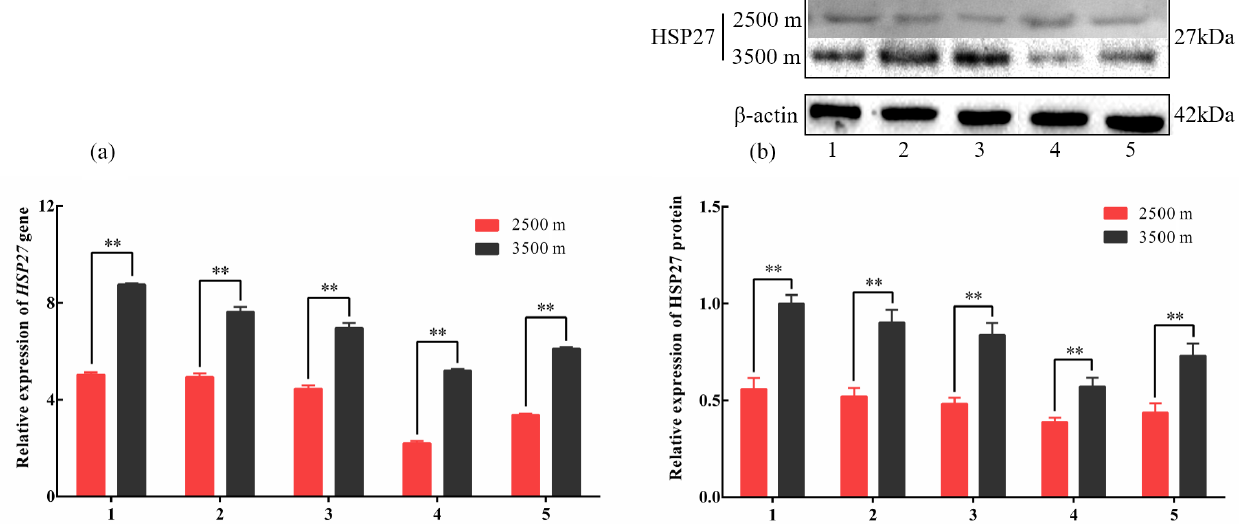
Figure 3. The expression levels of HSP27 mRNA (a) and protein (b) in five tissues obtained from yak living at different altitudes. Note that heart (1), liver (2), lung (3), kidney (4), and longissimus dorsi (5) tissue homogenates were analyzed for mRNA (a) and protein expression (b) . The expression values for the qPCR and western blot are given relative to the expression levels of the β -actin , GAPDH , and RPL19 gene and β -actin protein. The bars represent the mean ± SEM from three independent biological replicates, each performed with three (a) or eight (b) technical replicates. Asterisks denote significant differences: * P < 0 . 05; ** P < 0 . 01